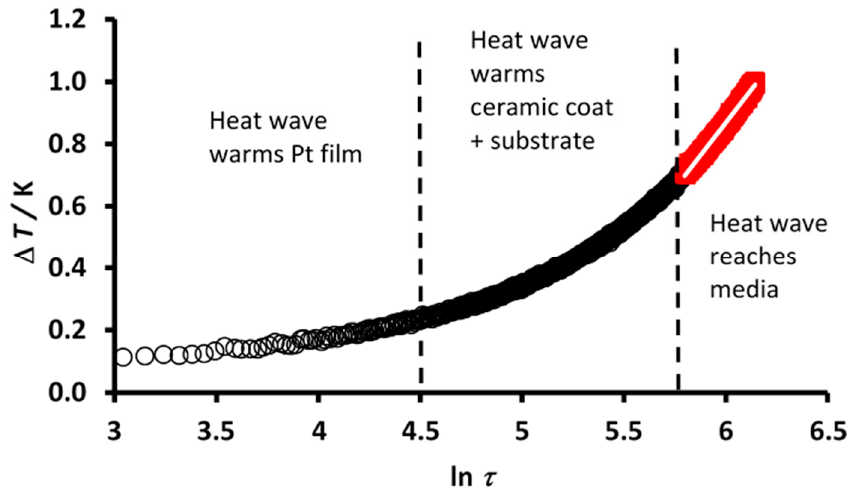
Figure 7. Dynamic sensor response for a run with the sensor immersed in air, with the optimal operating zone in red [49].